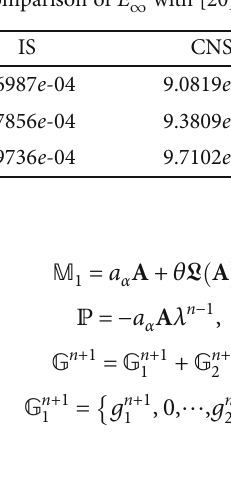
Table 7: Comparison of E ∞ with [20] for the Problem